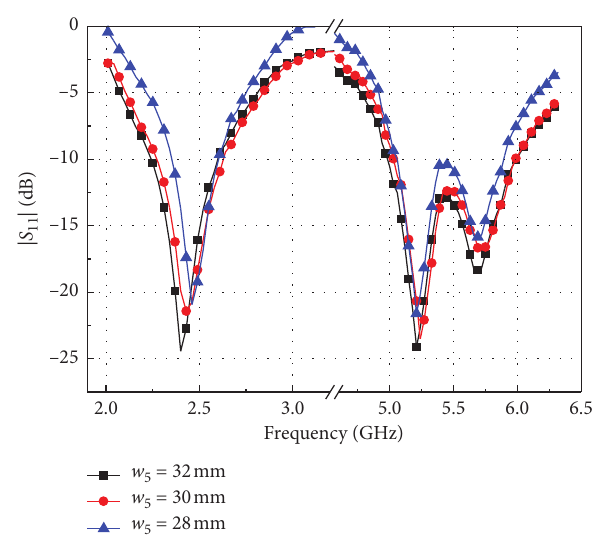
Figure 6: The simulated | S 11| for different w